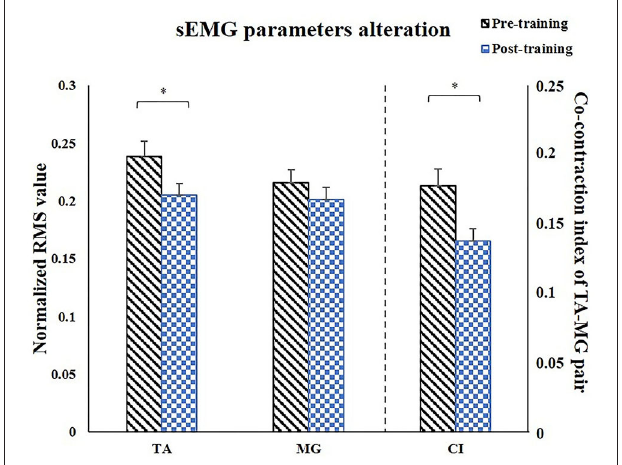
FIGURE 5 | Comparison of the paretic muscles using sEMG parameters. After training, RMS of TA significantly decreased, CI of TA/MG muscle pair significantly decreased. sEMG, surface electromyography; TA, tibialis anterior; MG, medial head of gastrocnemius; CI, co-contraction index; X, reactance; θ , phase angle. * P <